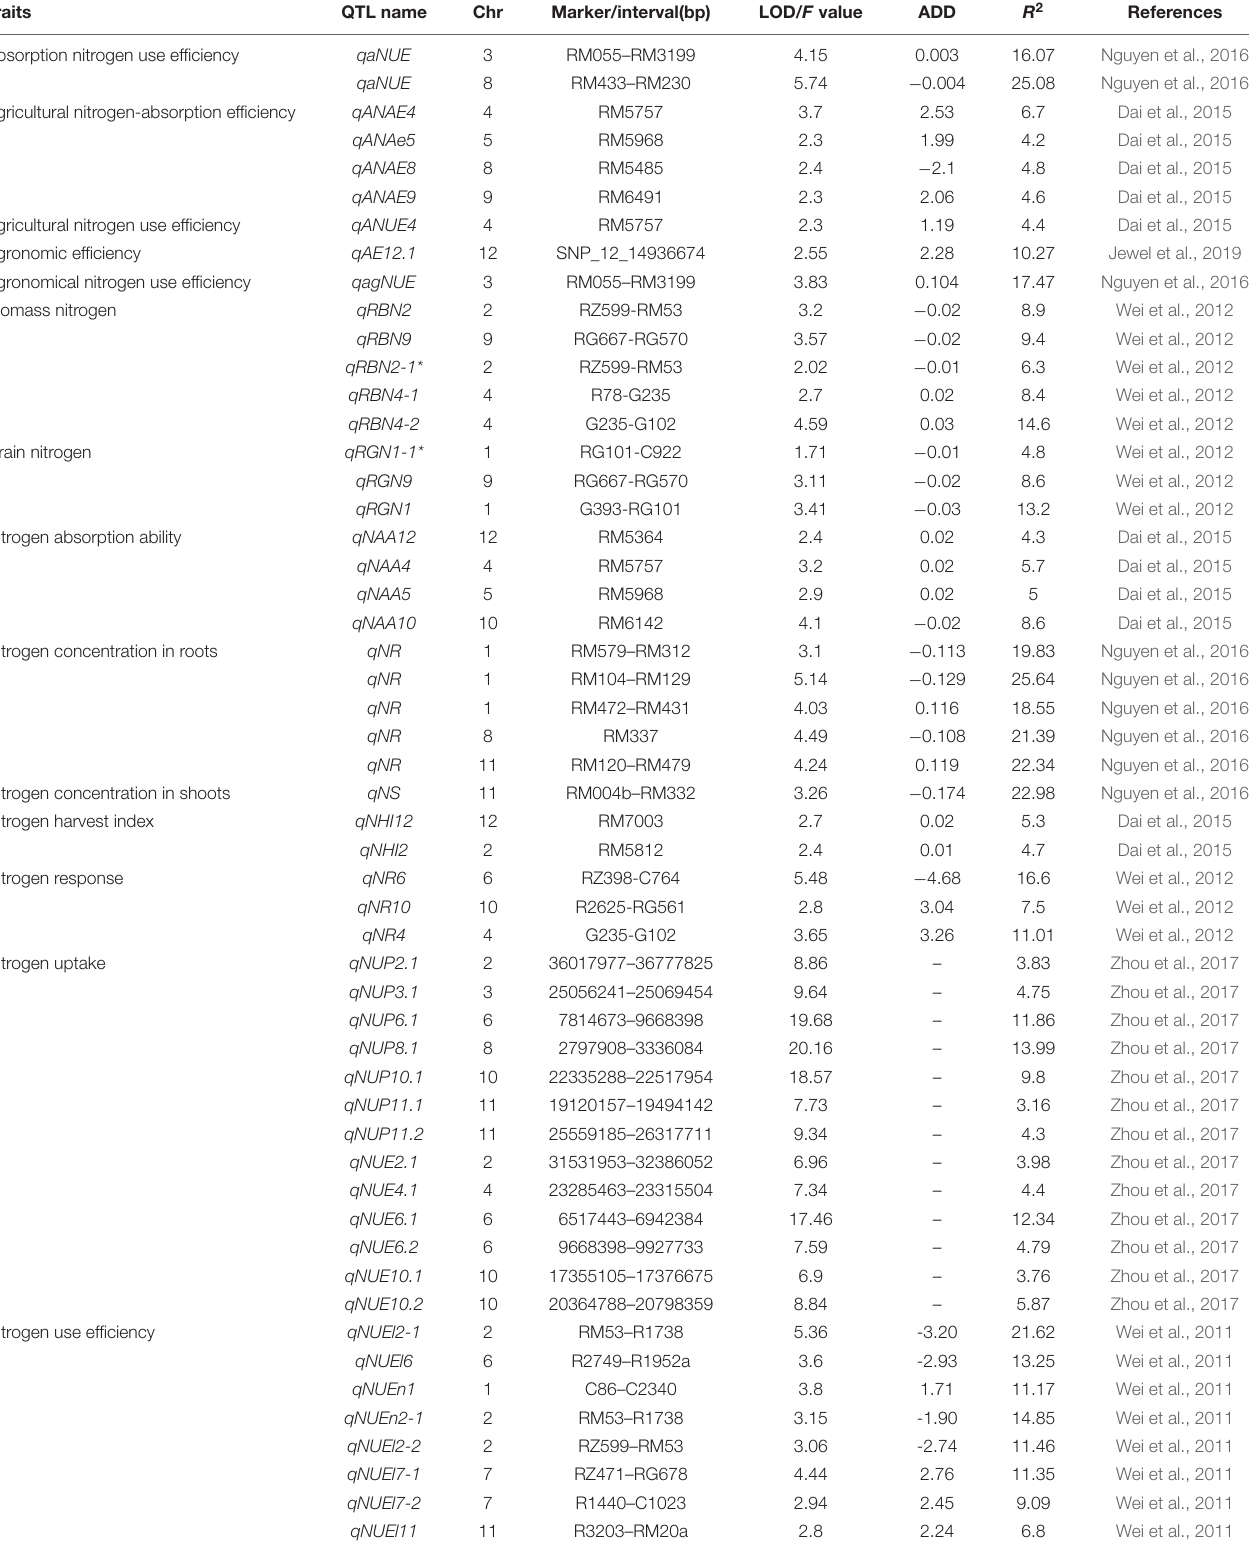
TABLE 2 | Detailed description of QTL associated with nitrogen use efficiency in